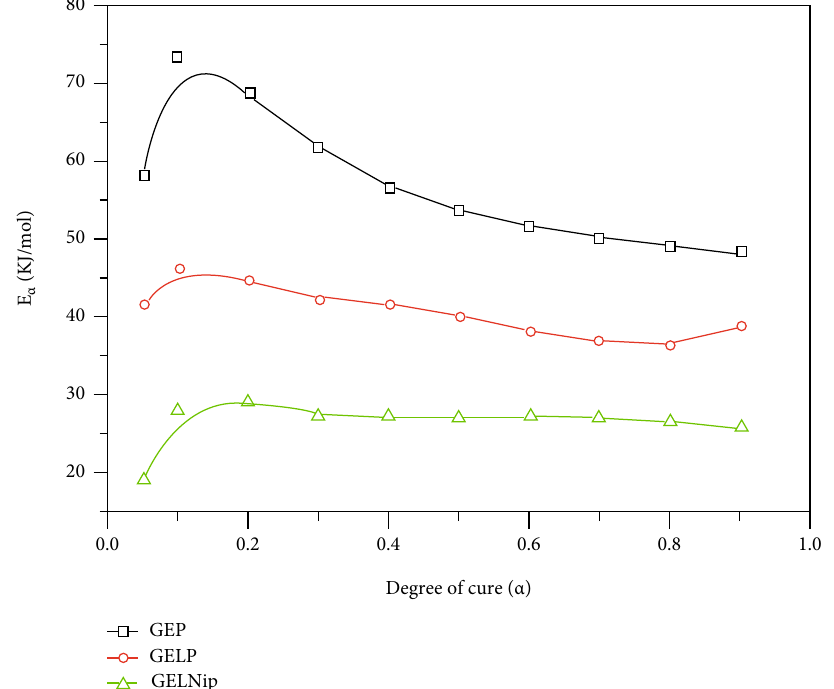
Figure 9: Variation of E α versus conversion for GEP, GELP, and GELNiP nanocomposites derived from the KAS